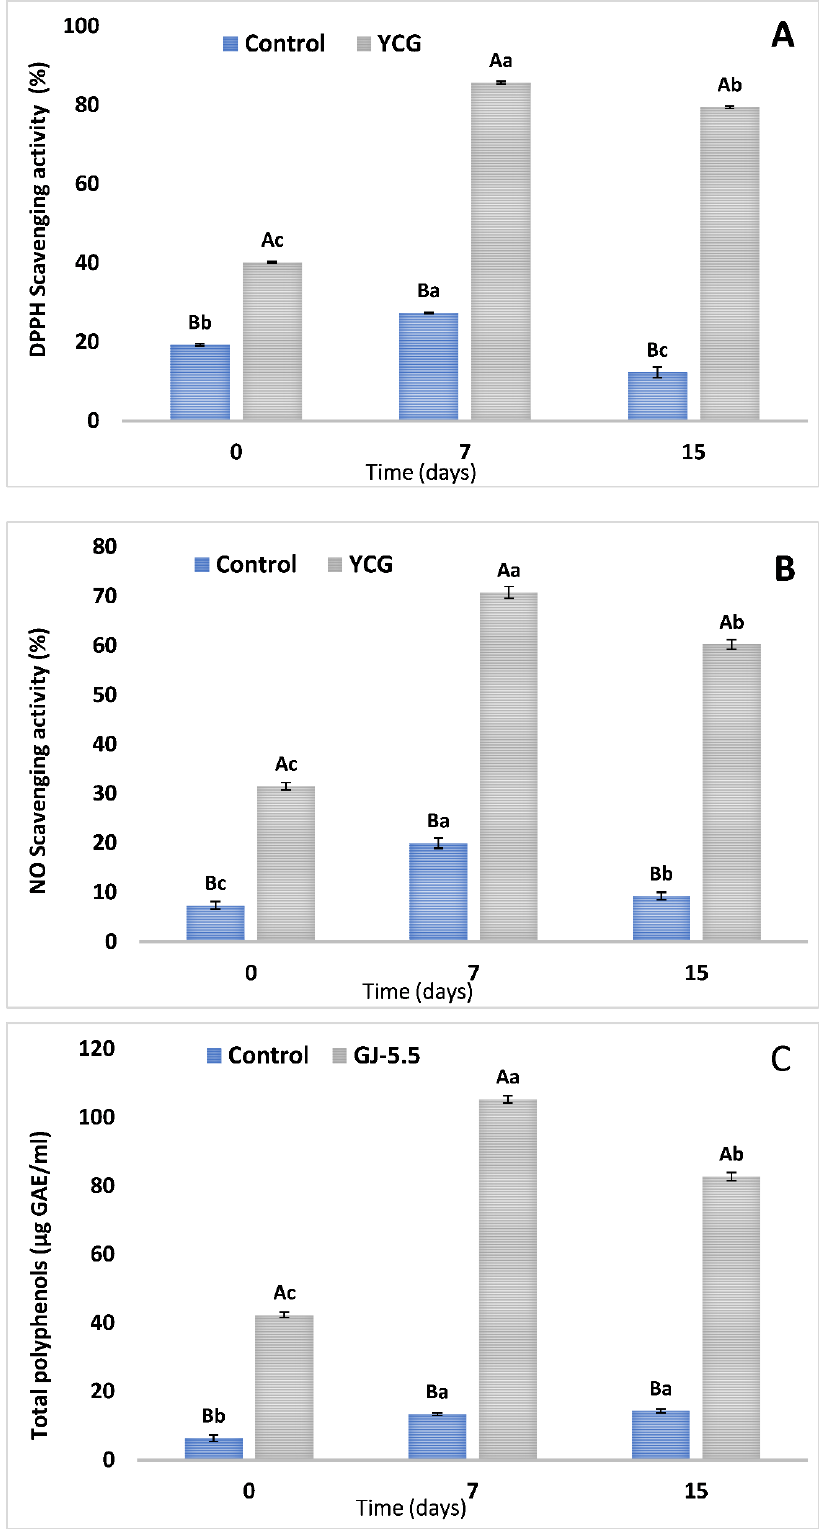
Figure 4. Antioxidant activity and total phenolic content of tested yogurts samples. ( A ) DPPH scavenging activity (%), ( B ) NO • scavenging activity (%), and ( C ) total polyphenols. Different uppercase superscripts point out significant ( p < 0.05) differences between the values for different treatments. Different lowercase superscripts point out significant ( p < 0.05) differences between the values during the storage period. Vertical bars present the standard division of the treatment